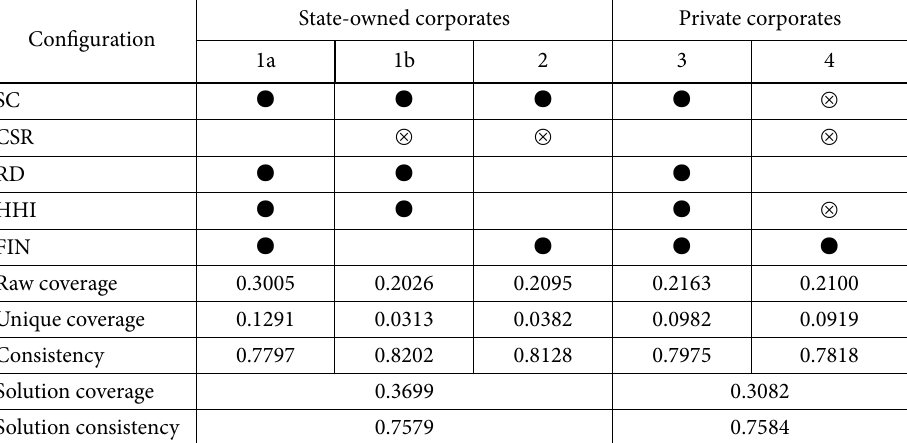
Table 11. Configurations leading to high-level risk-taking of state-owned and private corporates State-owned corporates Private corporates Configuration 1a